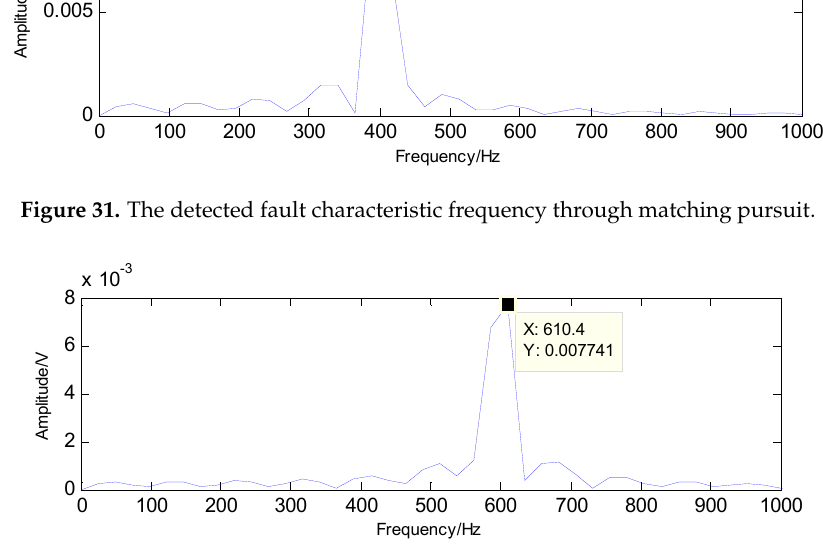
Figure 32. Second harmonic of the detected fault characteristic frequency through matching pursuit.